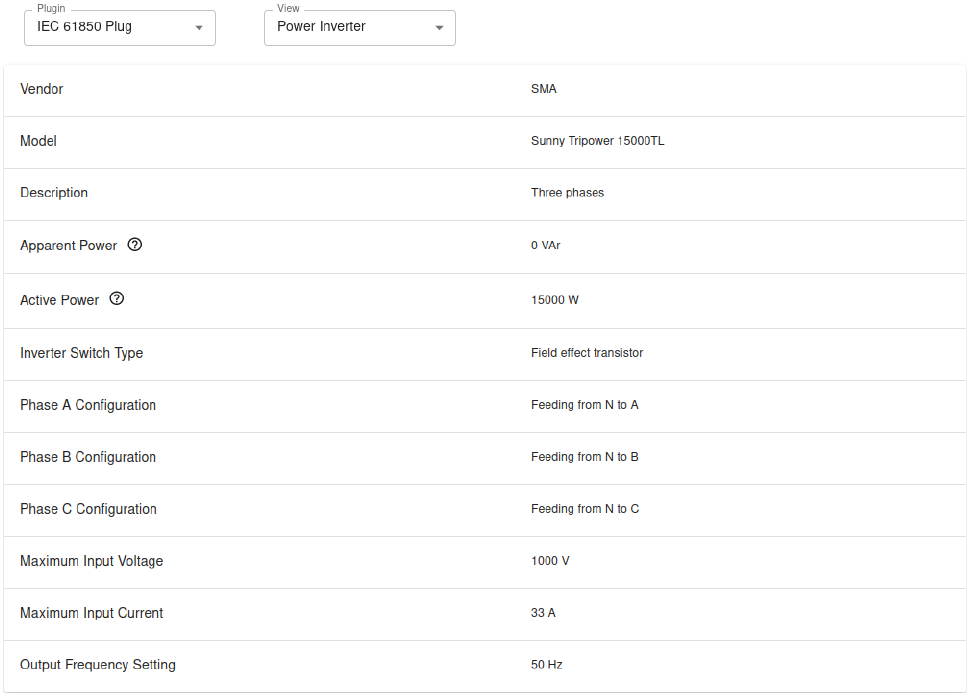
Figure 7. Screenshot of the IEC 61850 Plugin Visualizing the Master Data of an Power